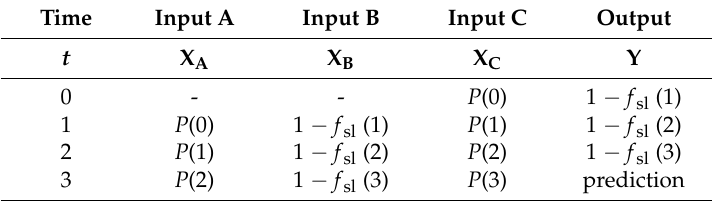
Table 1. Multi-to-one time series using P (interference potential) and 1 − f sl (seat load).